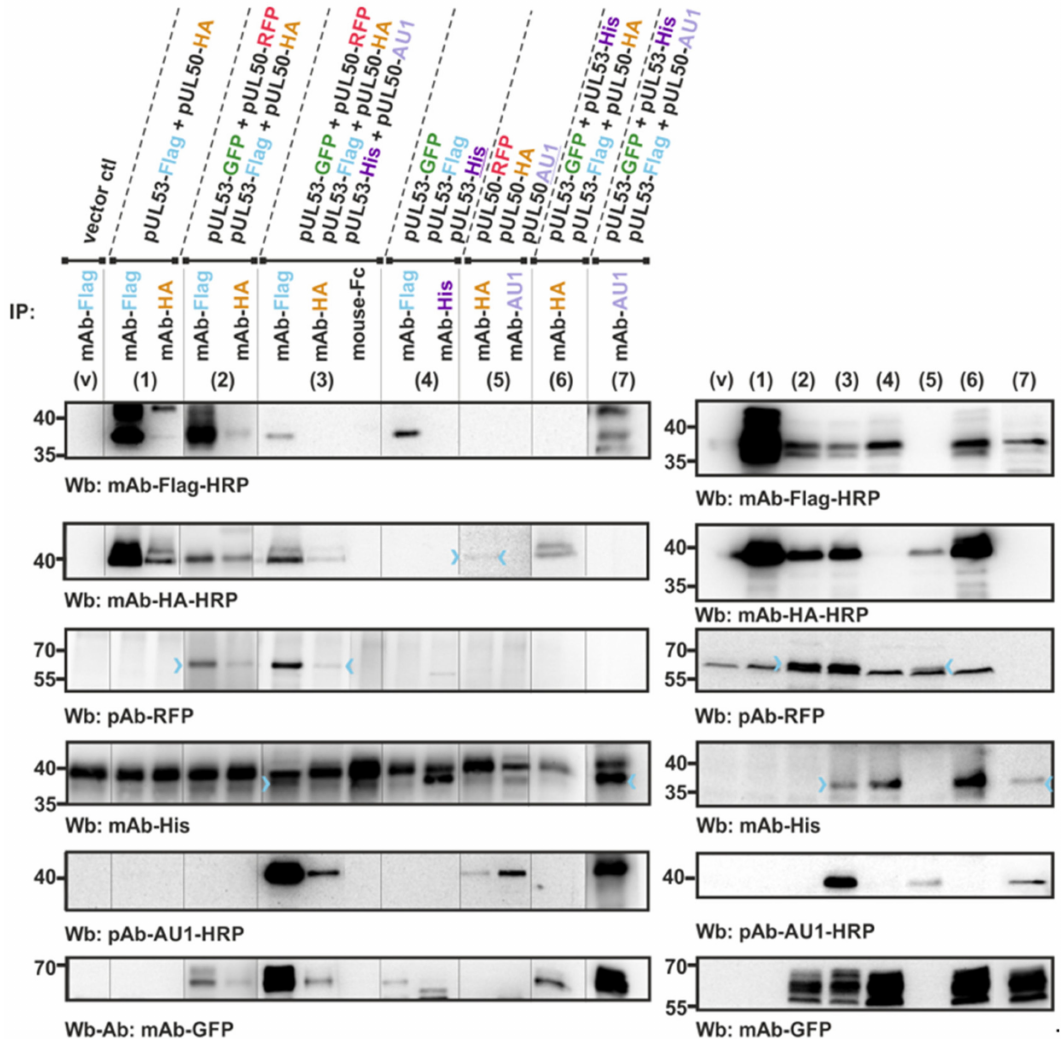
Figure 3. Cotransfection-based CoIP analysis as a confirmation test supporting the oligomeric interaction properties of the HCMV core NEC proteins pUL50 (groove) and pUL53 (hook). The indicated expression plasmids were used for the transient cotransfection of 293T cells and harvested at approx. 2 d p.t. for the preparation of total lysates. Expression levels of the individual proteins were monitored by the detection of lysate controls on Western blots (right panels: v, vector control; 1–6, coexpression protein samples, directly taken as the input for standard CoIP). The combinations of twofold, threefold, fourfold or sixfold coexpression is indicated above the immunoblots (left panels: v, vector control; 1–6, coexpression lysates used for CoIP; incubated at 4 ◦ C for approx. 4 h under rotation). Thereafter, the CoIP samples were washed and subsequently analyzed in a standard SDS-PAGE/Wb procedure, using the indicated antibodies for immunostaining (Wb). Colored arrowheads indicate weakly detectable